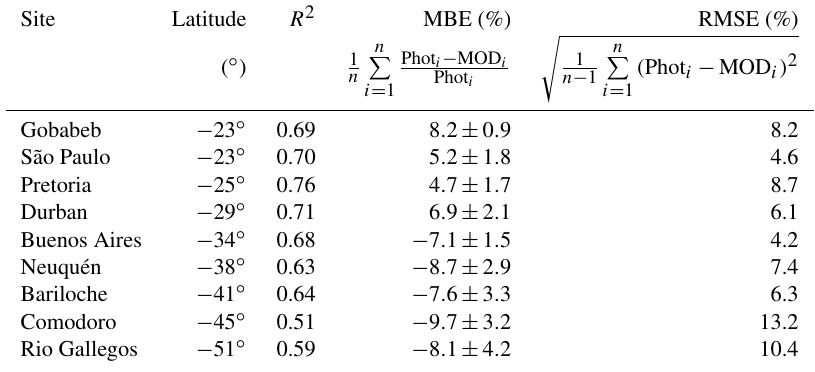
Figure 7. Daily mean AOD anomaly (%) at (a, b) São Paulo, (c, d) Bariloche, and (e, f) Gobabeb calculated from sun photometer (a, c, e) and MODIS (d, d, f) observations between 19 April and 31 May. Table 3. Statistical parameters for the comparison between sun photometer (Phot) and MODIS (MOD) observations for each